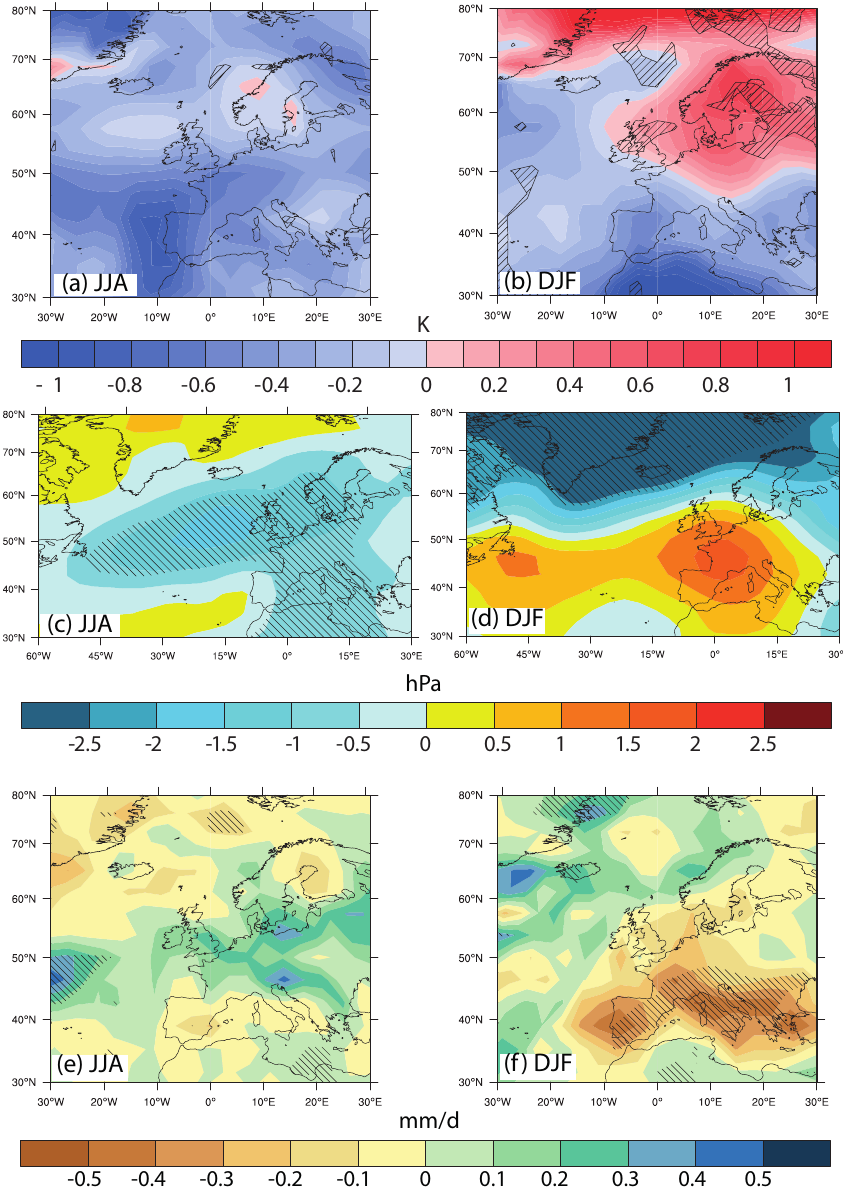
Fig. 3. Ensemble mean of post-volcanic surface temperature (a, b) , sea level pressure (c, d) and precipitation (e, f) anomalies, showing the difference between VOLC (4years: 1810, 1816, 1832 and 1836) and CTRL1780 (3 × 60=180years) in the JJA (left panels) and DJF (right panels) season. For all plots, dashed areas show significant changes in a 10% t test (two-sided t